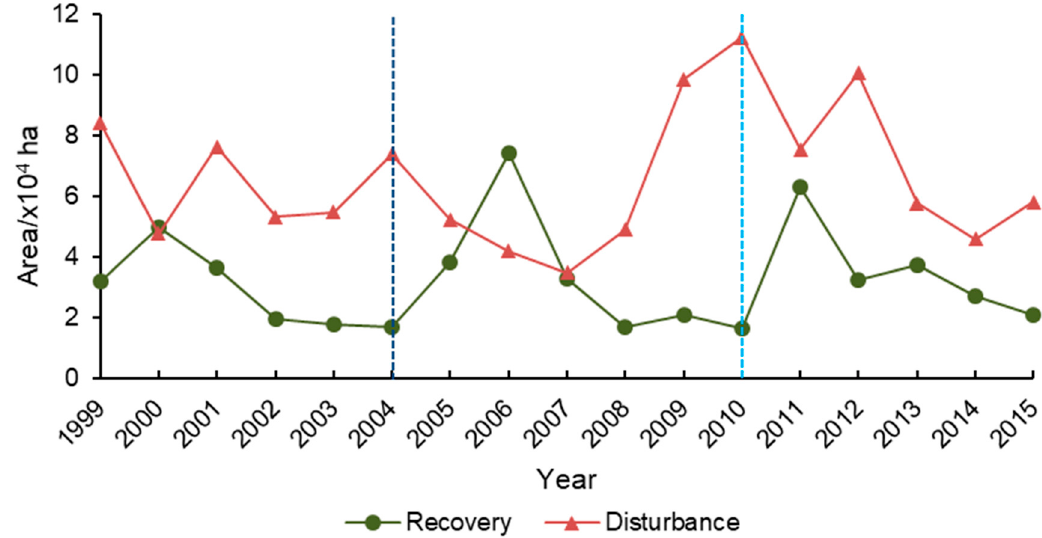
Figure 3. Interannual area change in forest disturbance and recovery. The area of forest disturbance in the study area was significantly larger than that of forest recovery. The forest area in the whole district showed a net loss trend, and the total forest loss area was 0.56 × 10 6 ha. The dotted line is used to divide the time period.